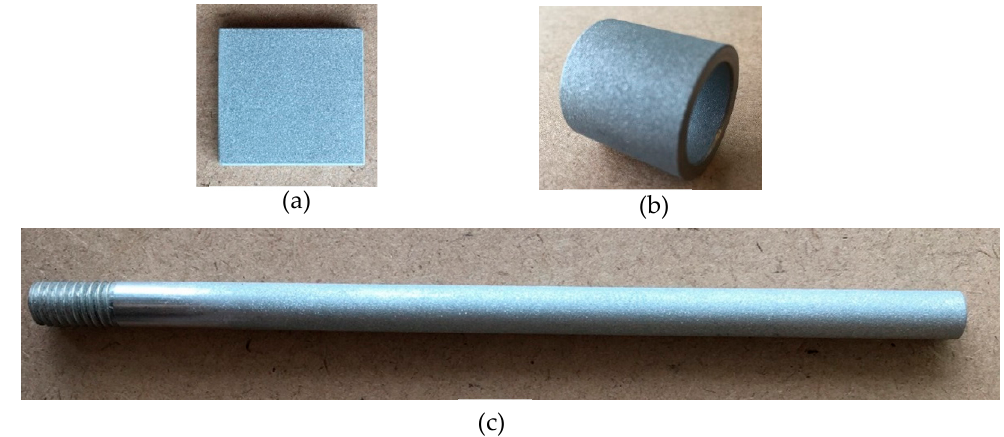
Figure 6. Stainless steel substrates used in this study: ( a ) flat; ( b ) cylindrical; and ( c ) rod.